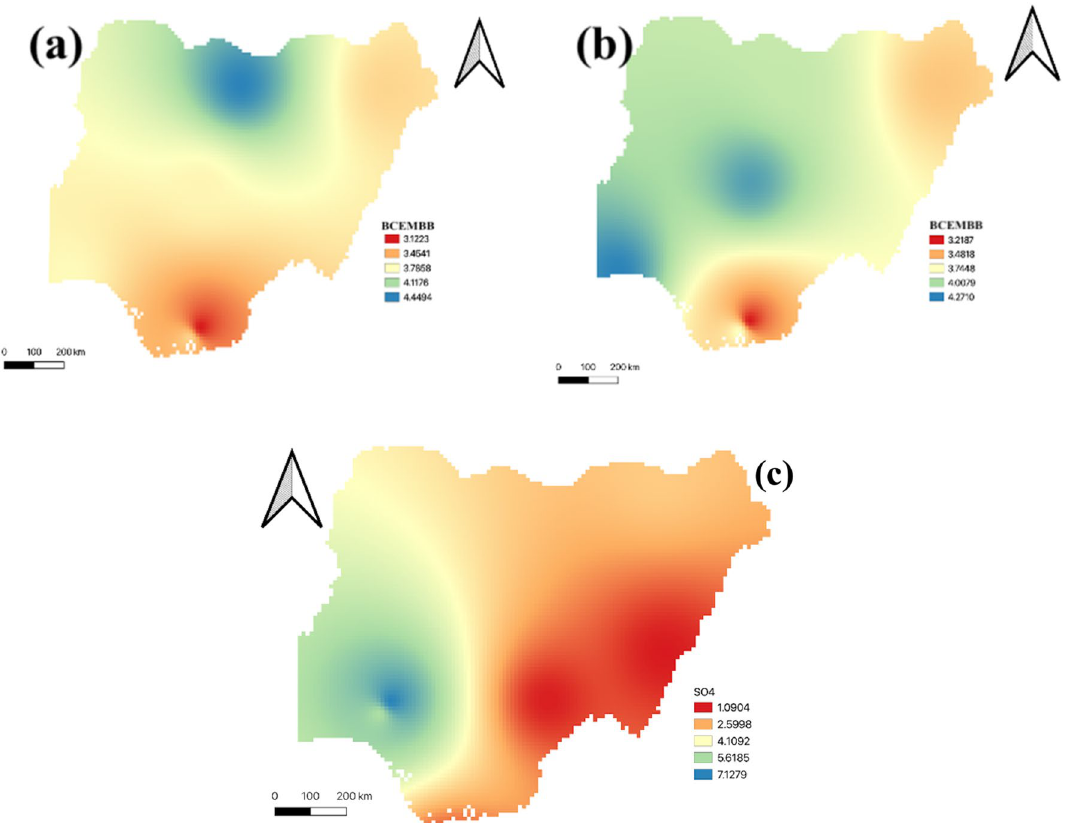
Figure 5. State of black carbon and sulphate particulates ( a ) Black Carbon Biomass Burning Emissions (2010–2014) ( b ) Black Carbon Biomass Burning Emissions (2015–2019) ( c ) Sulphate